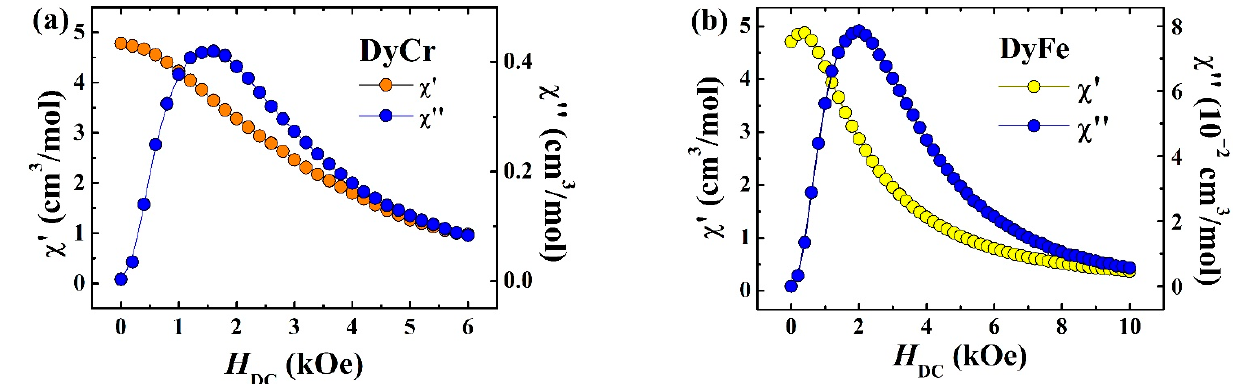
Figure 5. Effect of dc field on the real and imaginary parts of the low-temperature ac magnetic susceptibility of the complexes 1 , ( a ) DyCr and 2 , ( b ) DyFe. The curves were recorded at T = 1.8 K, f = 100 Hz and h ac = 4 Oe for the sample 1 and T = 2.0 K, f = 117 Hz and h ac = 5 Oe for the sample 2 .